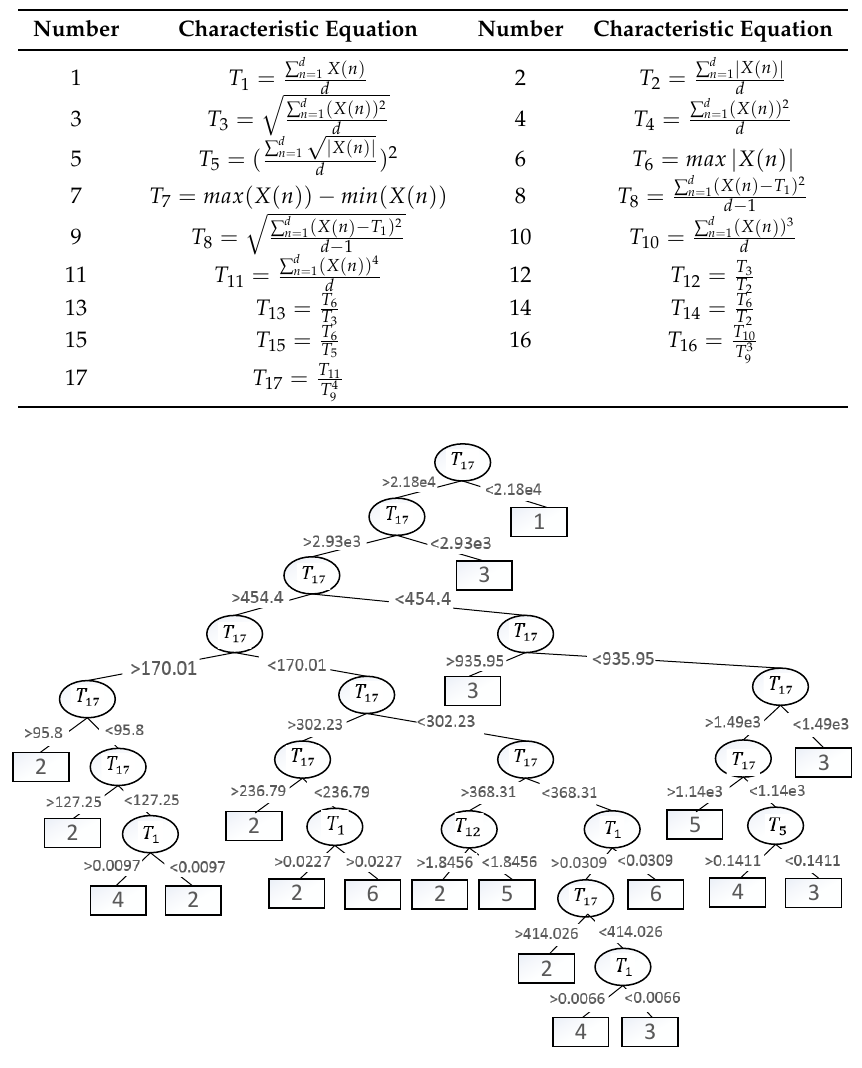
Table 3. Time domain analysis of bearing fault data.